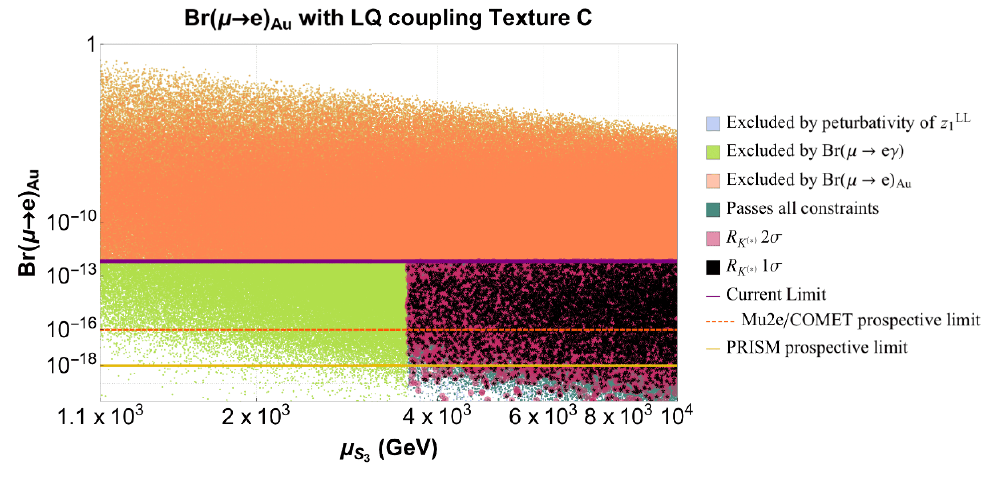
Figure 18 . Indicative plot of the allowed parameter space scans showing (cid:22) S leptoquark coupling matrix Texture C. The purple line indicates the current Br( (cid:22) ! e ) Au cut-o(cid:11), the dotted orange (yellow) line indicates the prospective cut-o(cid:11) from the Mu2e/COMET (PRISM) experiment. The light green region shows parameter space that is excluded by Br( (cid:22) ! e(cid:13) ). The orange region of the parameter space is constrained by Br( (cid:22) ! e ) Au , the teal region is